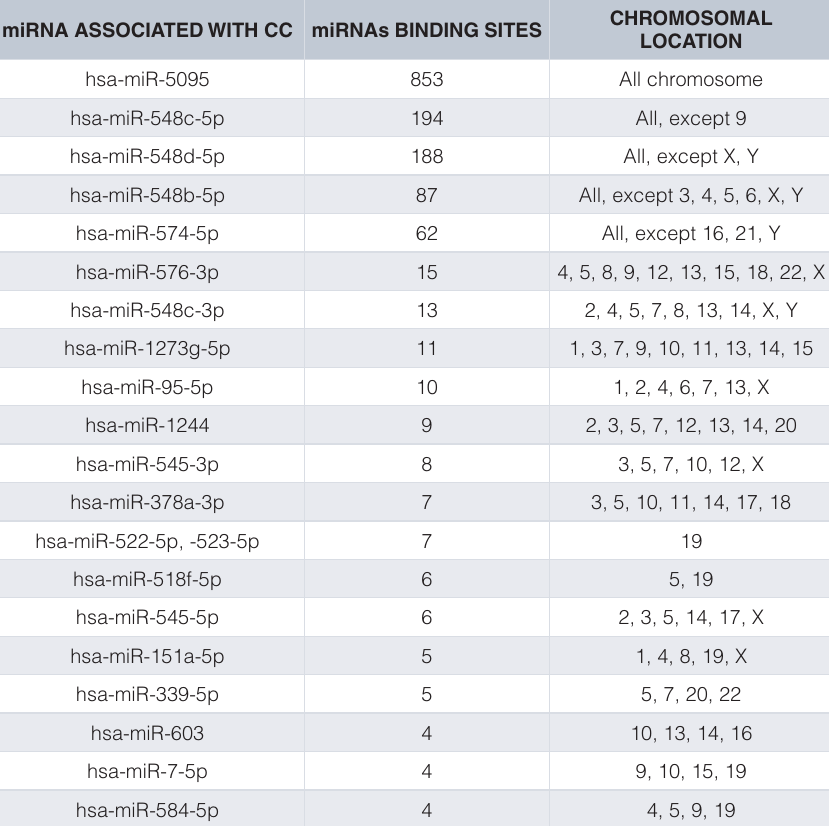
Table 3. Chromosomal location and frequency of miRNA binding sites associated with CC 1